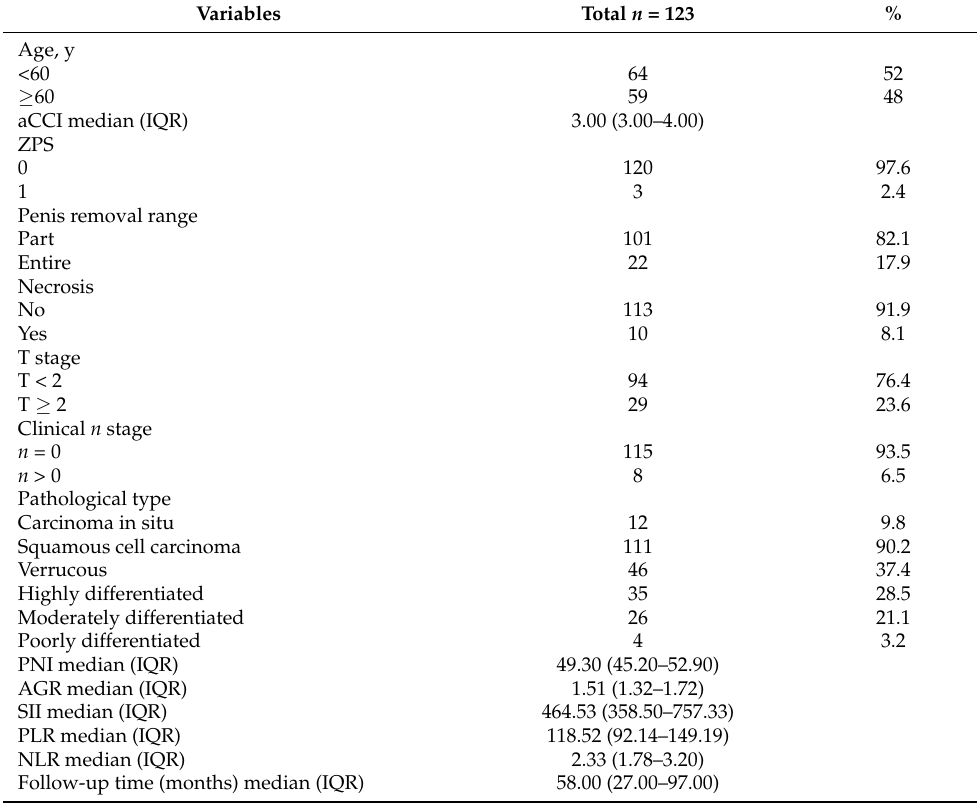
Table 1. Characteristics of the 123